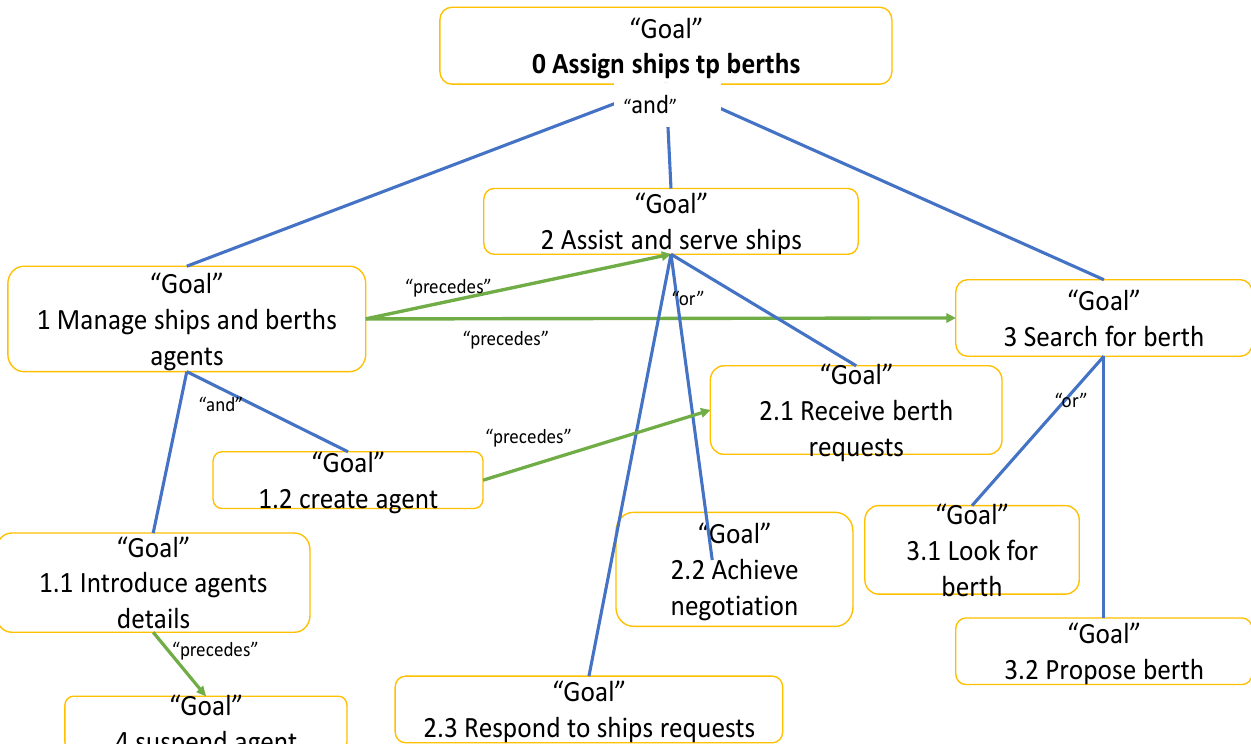
Figure 5. Refined goal model of O-MaSE.